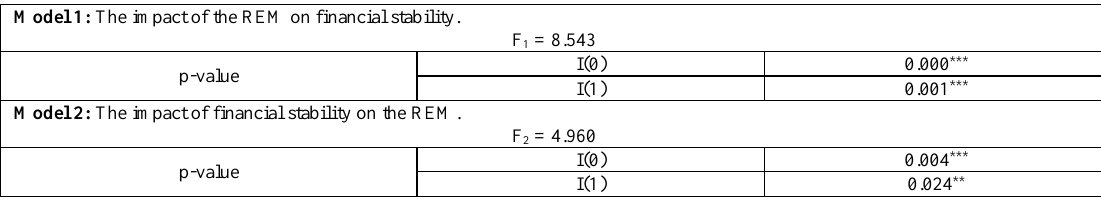
Table 3. Cointegration test results